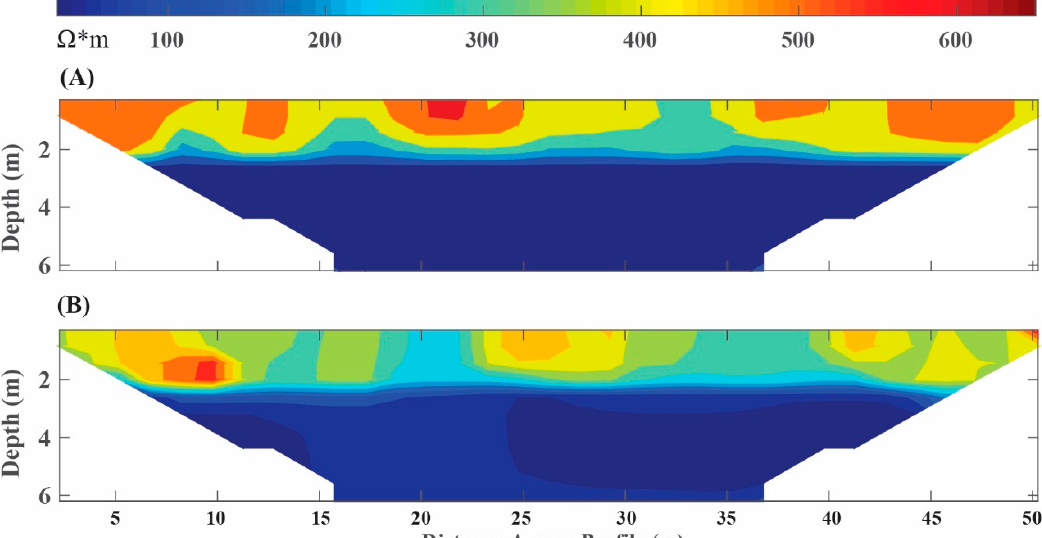
Figure 6. Pre-restoration and post-restoration scatter plots and regression lines between Marian Meadow and Control Meadow depth to groundwater (m). Solid line indicates a pre-restoration relationship while the dashed lines indicate post-restoration relationships.